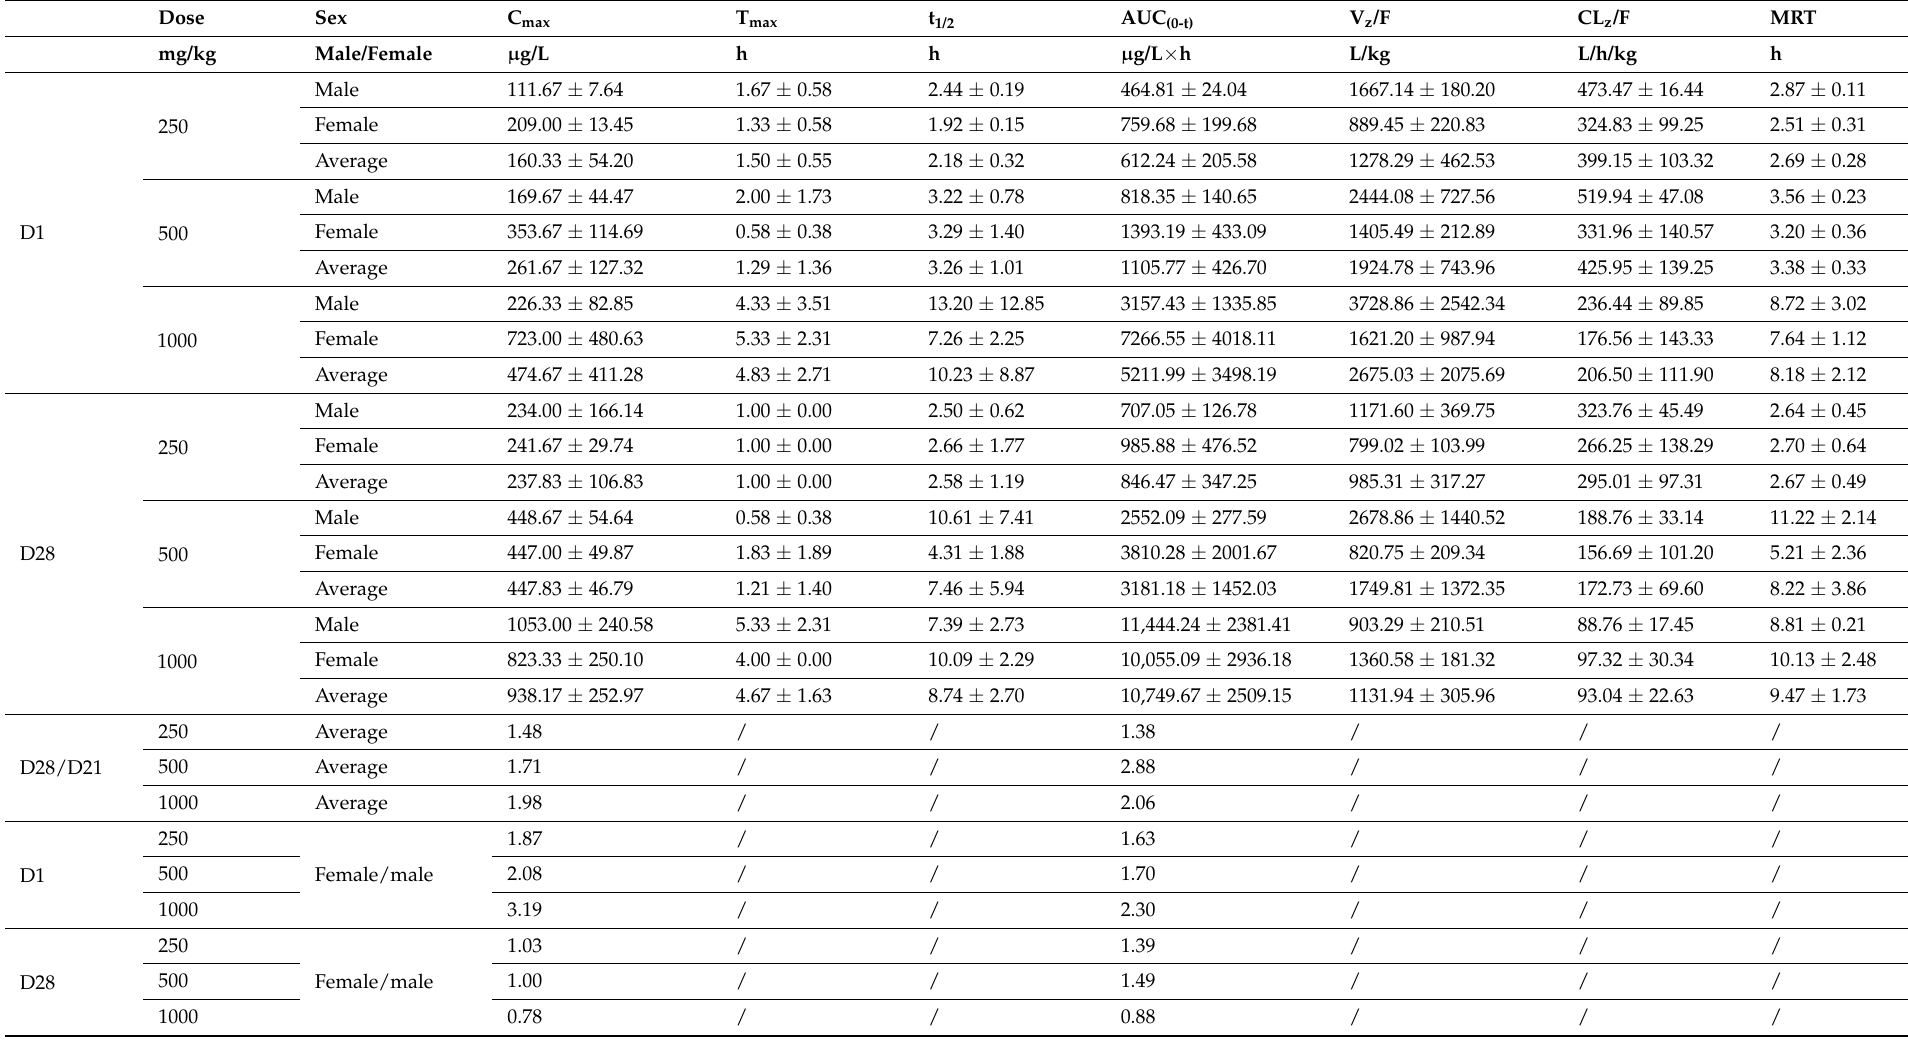
Table 6. Toxicokinetic parameters of PQQ after single and 28-day repeated administration in rats at 250 mg/kg, 500 mg/kg and 1000 mg/kg dose